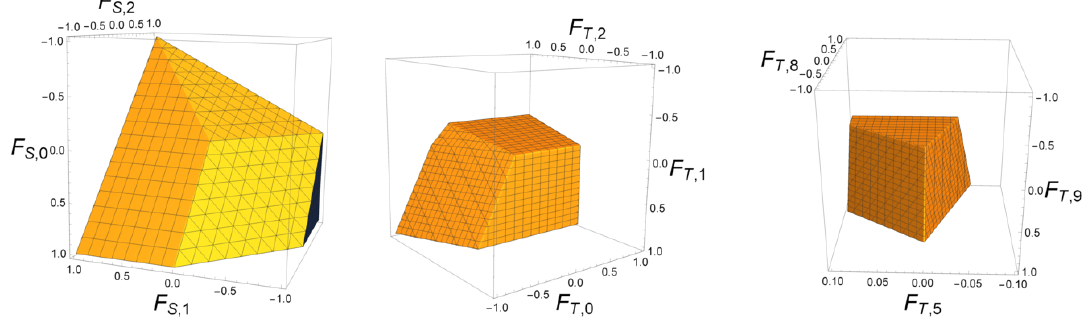
Figure 23 . Representative cases for three S -type or three T -type operators. Allowed parameter spaces are described by pyramids.